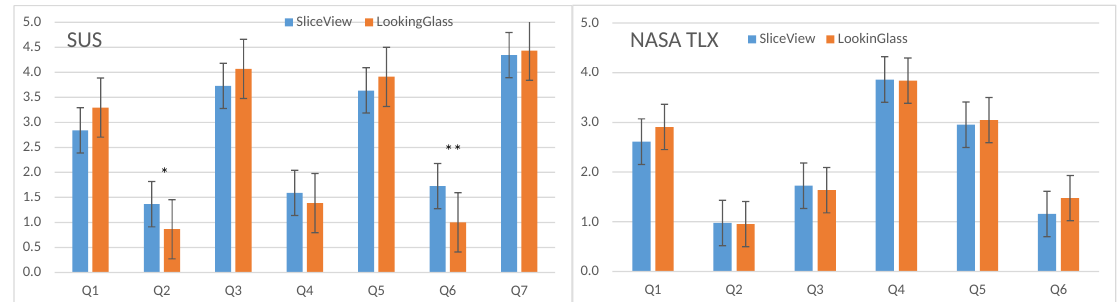
Figure 11. SUS and NASA TLX questionnaires split by question and condition. (* refers to p -value ≤ 0.05; ** refers p -value ≤